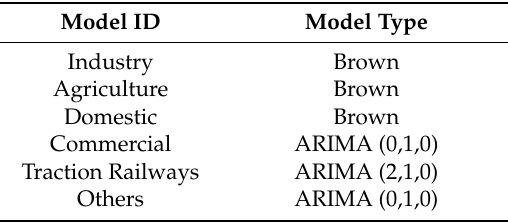
Table 6. Summary of Expert model.